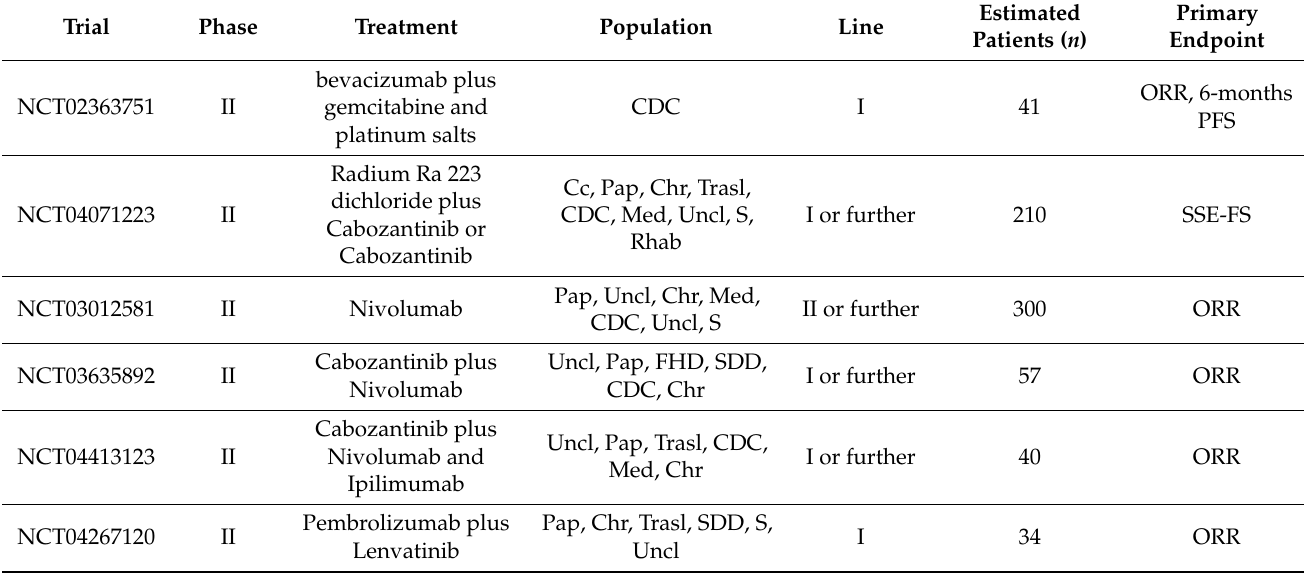
Table 3. Ongoing clinical trials evaluating treatment regimens for non-clear renal cell carcinoma patients. CDC: collecting duct carcinoma; ORR: objective response rate; Cc: clear cell renal carcinoma; cell; Pap: papillary renal cell carcinoma; Chr: chromophobe; Trasl: microphthalmia-associated transcription (MiT) family translocation renal cell carcinoma; Med: renal medullary carcinoma; uncl: unclassified carcinoma; S: renal cell carcinoma with a prominent sarcomatoid component; Rhab: renal cell carcinoma with a prominent rhabdoid component; FHD: Fumarate Hydratase Deficient Renal Cell Carcinoma; SDD: Succinate Dehydrogenase Deficient Renal Cell Carcinoma; SSE-FS: 1. Symptomatic skeletal event (SSE)-free survival